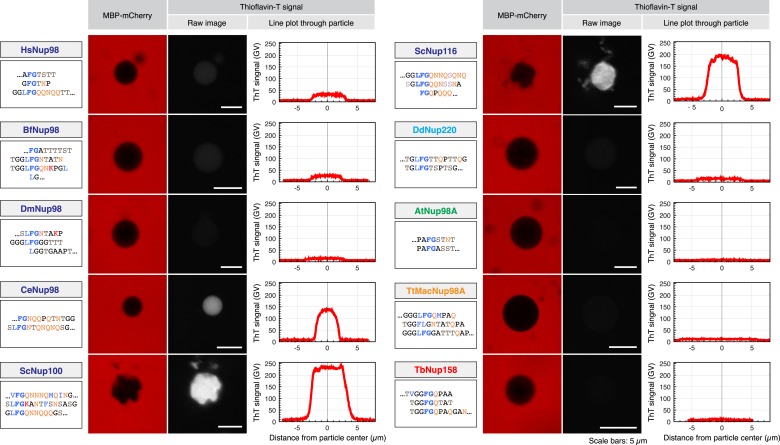
Different modes of inter-FG repeat interactions within FG particles.The indicated Nup98 FG domains were studied. Representative repeat sequences are shown in single letter code (see Supplementary file 2 for complete sequences). Particles were formed at 5 µM (HsNup98, TtMacNup98, TbNup158) or 10 µM FG domain concentration (all other FG domains). The suspensions were afterwards supplemented with 3 µM MBP-mCherry and 1 µM ThioflavinT, a diagnostic dye for the presence of amyloid-like cross-β-structures. Particles were detected based on exclusion of MBP-mCherry. ThioflavinT was excited at 405 nm and detected in a 460–500 nm window. Graphs show quantitations for the measured signals (gray value scales). ScNup100 FG particles gave the strongest signal. For Table 1, all Thioflavin signals were normalized to the Nup100 signal.